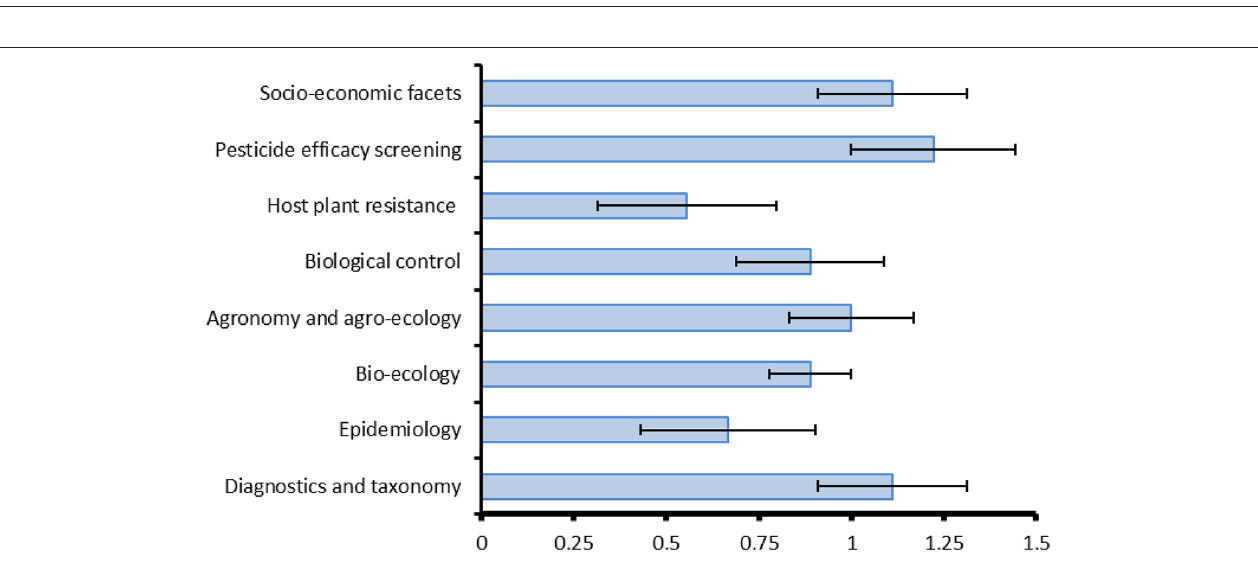
FIGURE 3 | Comparative ranking (x ± SE) of biological control in terms of Rogers’ five innovation attributes. For each attribute, respondents from 9 Asia-Pacific countries rank the performance of biological control and biopesticides as compared to synthetic pesticides. Positive values reflect how biological control innovations are perceived to outperform pesticide-based approaches. Attributes are described in further detail in Appendix III .